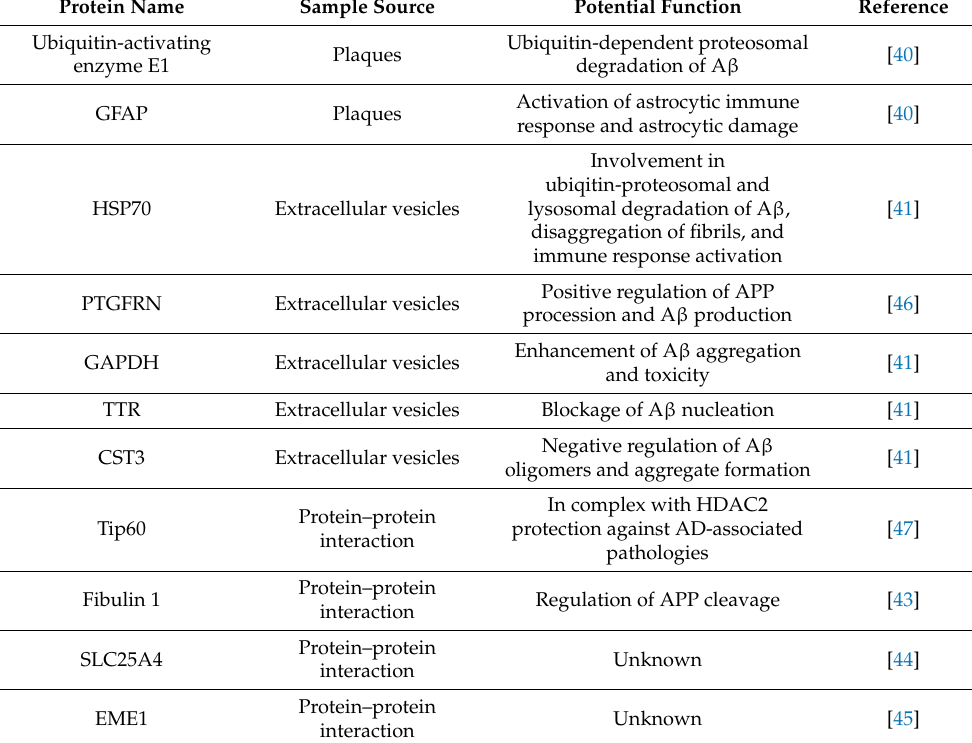
Table 1. Potential interactors of A β and their function in AD